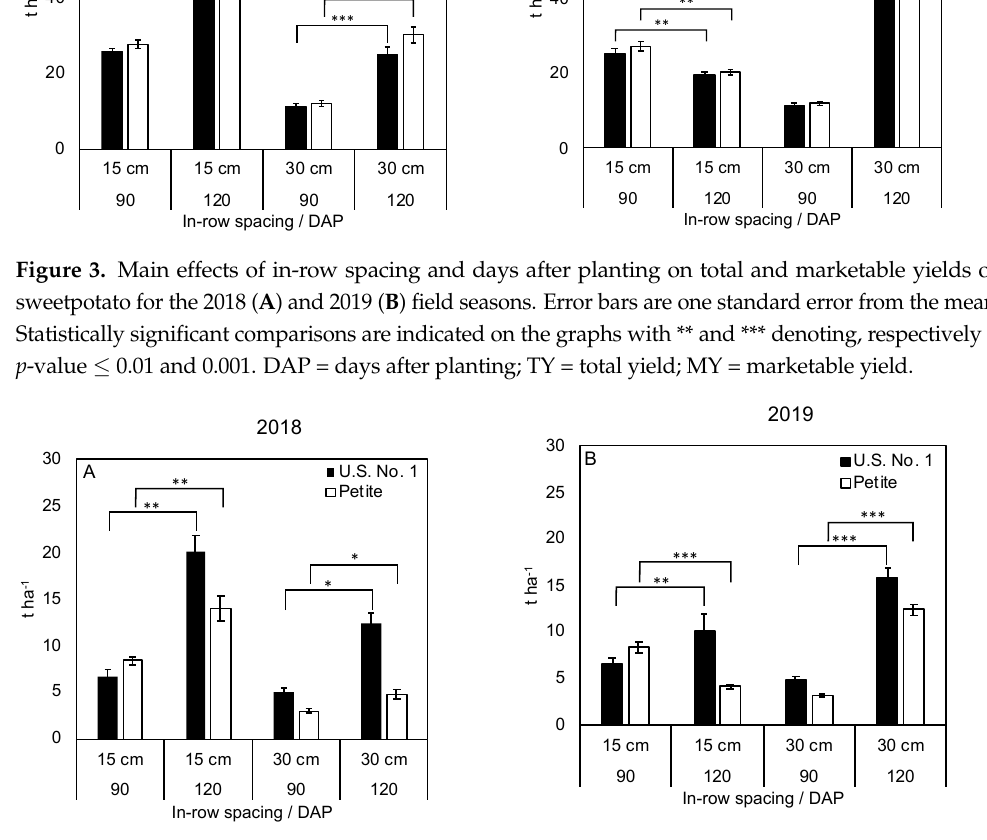
Figure 4. Main effects of in-row spacing and days after planting on U.S. No. 1 and Petite sweetpotato roots for the 2018 ( A ) and 2019 ( B ) field seasons. Error bars are one standard error from the mean. Statistically significant comparisons are indicated on the graphs with *, ** and *** denoting, respectively a p -value ≤ 0.05, ≤ 0.01 and 0.001. DAP = days after planting. To further examine grade standards for U.S. No.1 and Petite sweet potato, all varie- ties tested during both years were graded meticulously, measured, and weighed to report for differences between jumbo, canner, and cull categories (Table 3). Table 3. Main effects (by variety, days after planting, and in-row spacing) on yields of U.S. No. 1, Petite, Jumbo, Canner, and Cull sweet potato grades, total and marketable yield for the 2018 (A) and 2019 (B) field season. In-row Vari- Year DAP ety